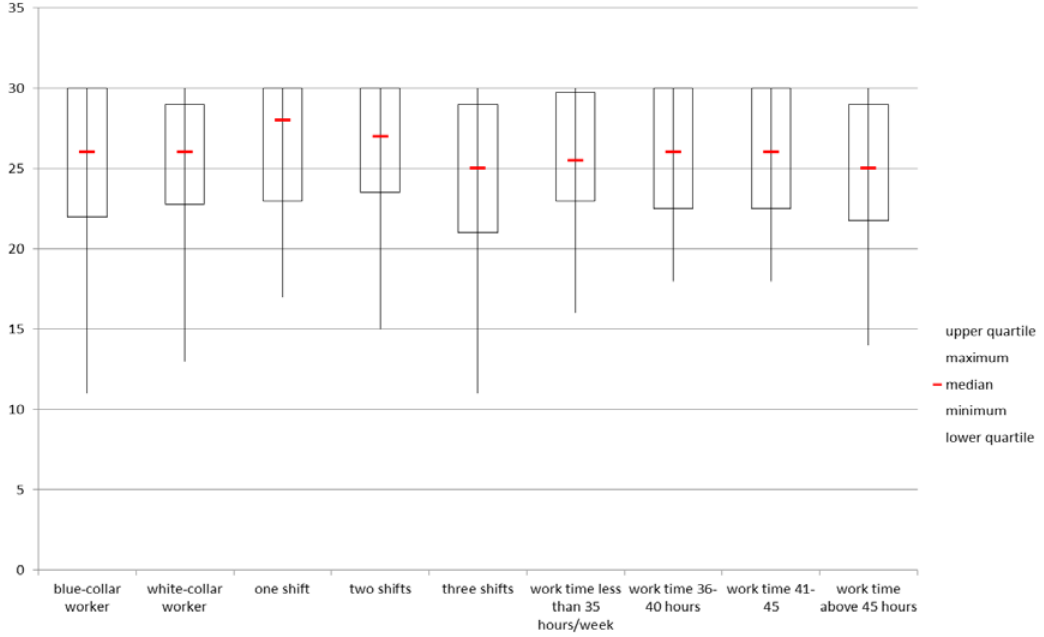
Figure 1. Basic distribution of the work-family balance scores across worker characteristics, N = 383.